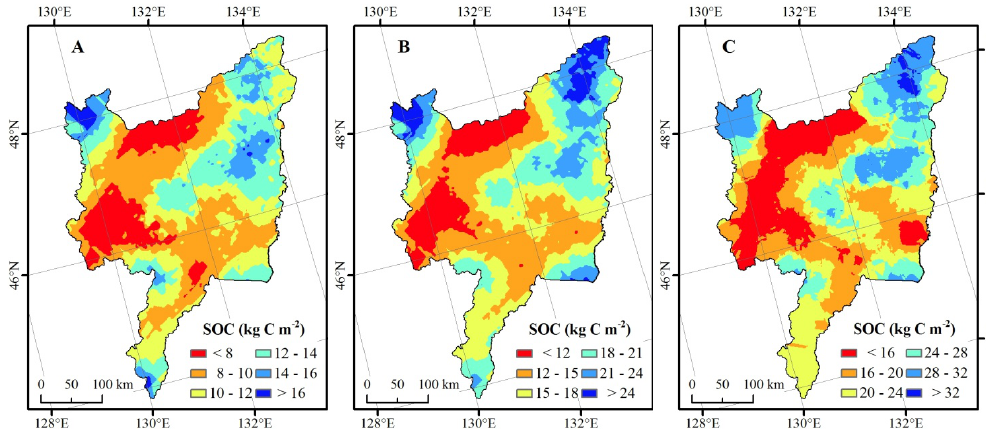
Figure 4. Spatial pattern of SOC storage at different soil depths ( (a) : 0–30cm; (b) : 0–60cm; (c) :